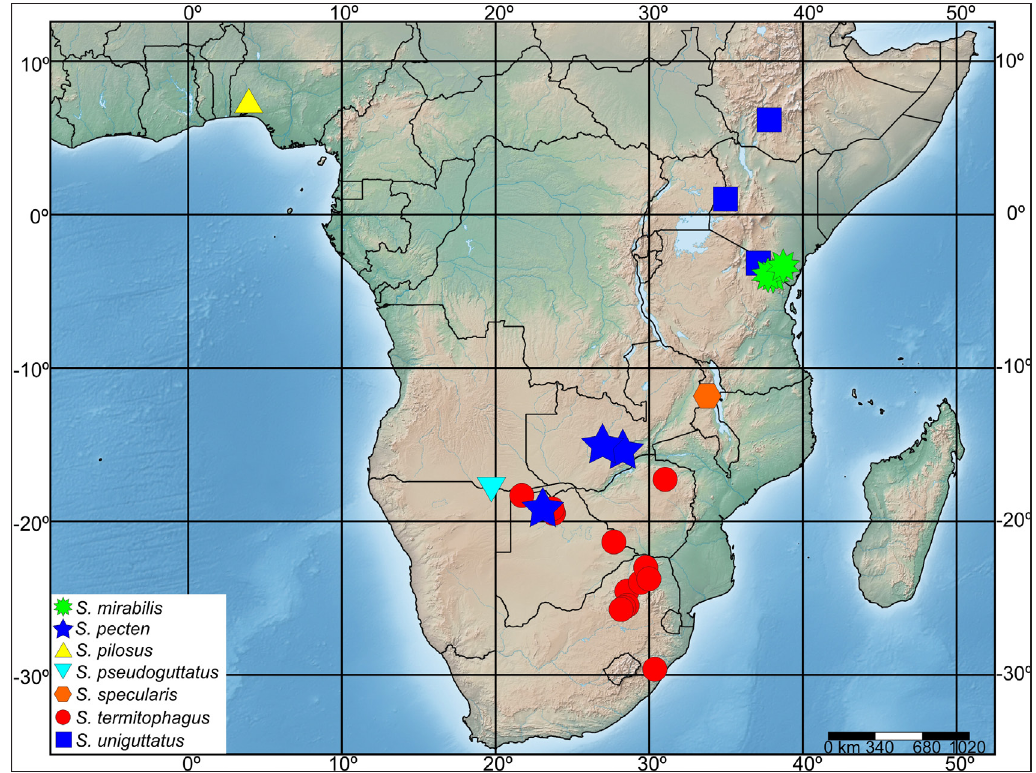
Fig. 514. Collecting localities of seven African species of Stenaelurillus